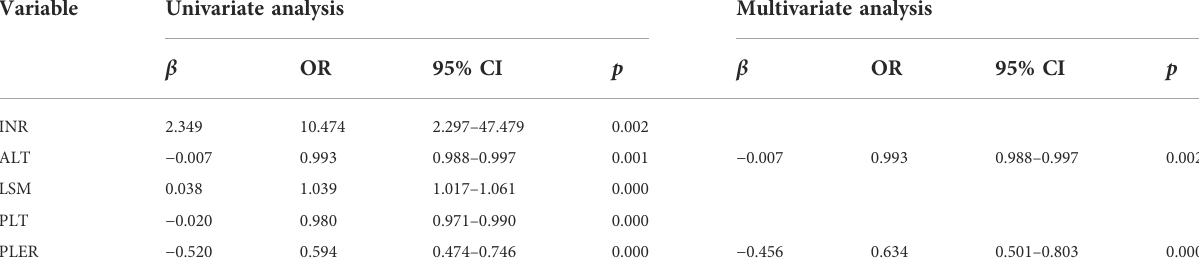
TABLE 3 Univariate and multivariate analyses of risk factors associated with HRVs in patients with HBV-related liver cirrhosis beyond Baveno VI criteria. Variable